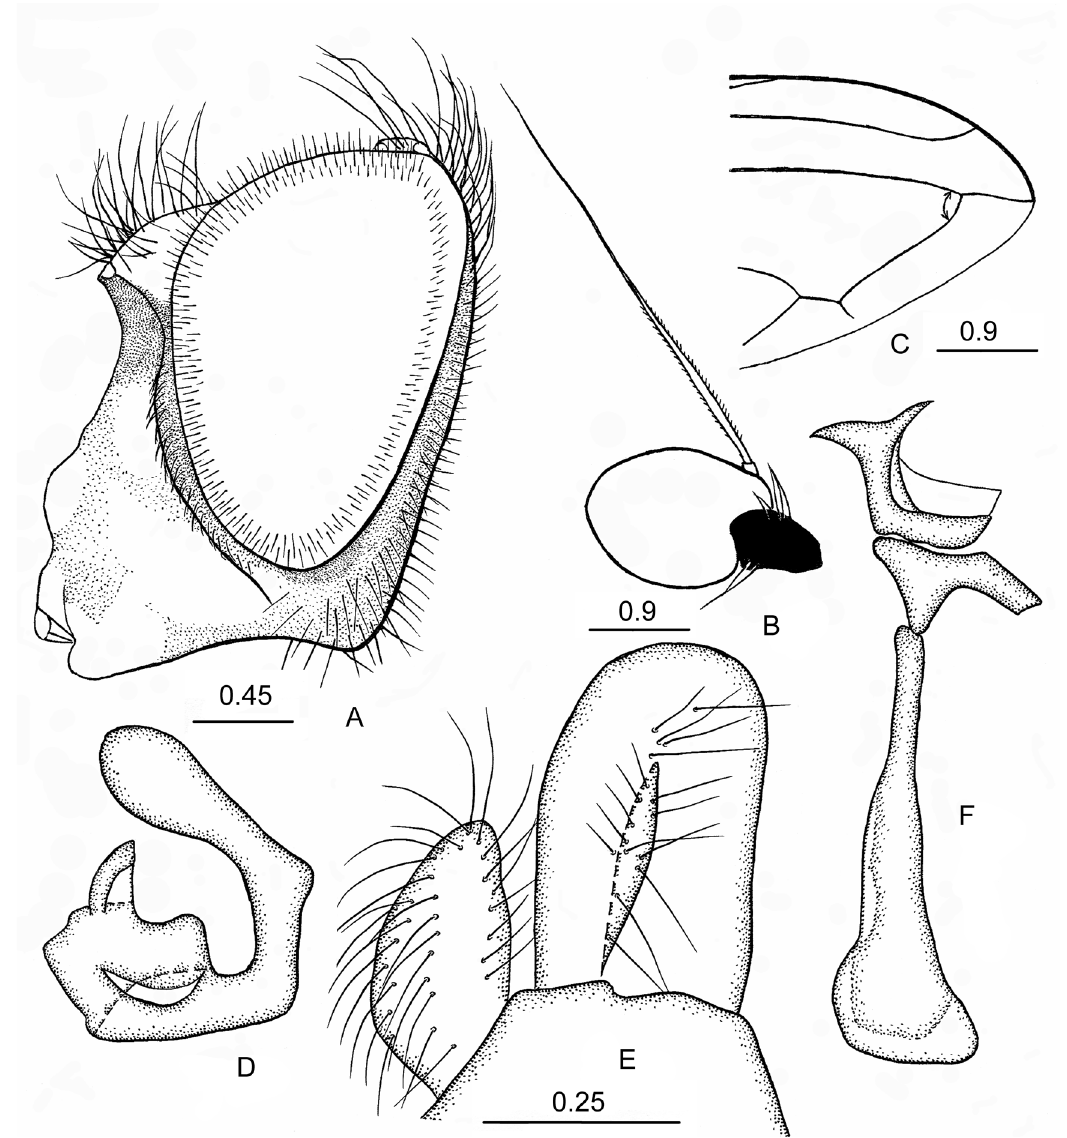
Fig. 7. Cheilosia ( Cheilosia ) angusta sp. nov., holotype, ♂ (IBSJW/NME). A . Head, lateral view. B . Antenna, lateral view of pedicel and basoflagellomere. C . Tip of wing. D . Superior lobe of hypandrium, lateral view. E . Surstylus and gonocercus, lateral view. F . Aedeagus and aedeagal apodeme, lateral view. Scale bars indicated in